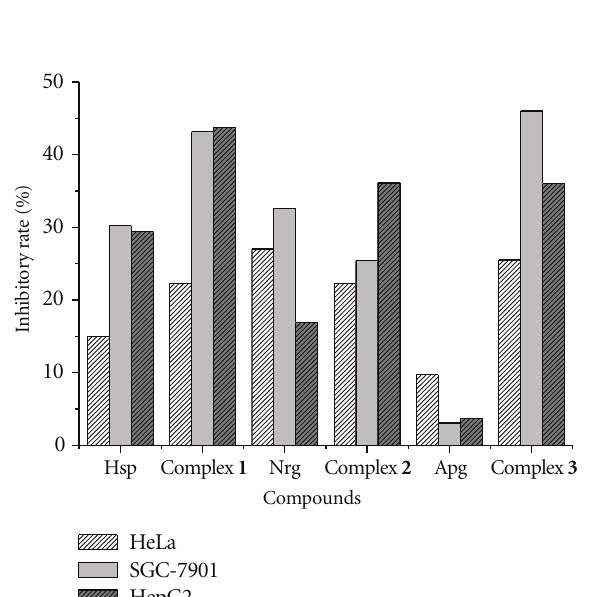
molecule between the base pairs of DNA [37, 38]. Generally, active compounds are required to possess approximately planar structure, with a medium-sized planar area and some hydrophobic character. In order to investigate the binding properties with DNA of Hsp and its copper(II) complexes, which have significant e ff ect against the tested cell lines, a series of spectroscopic studies including UV-Vis, fluorescence, and CD spectra were carried